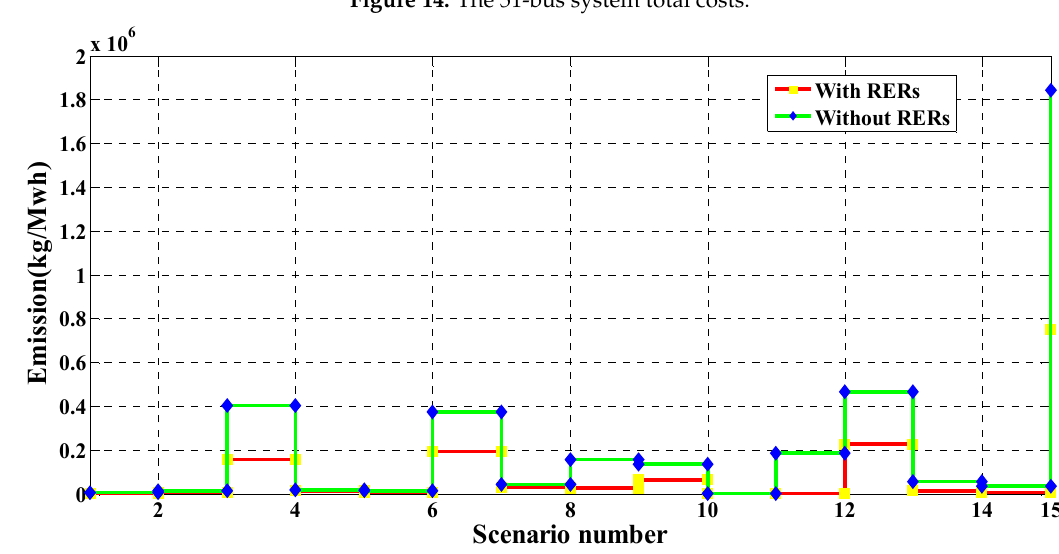
Figure 14. The 51-bus system total costs.